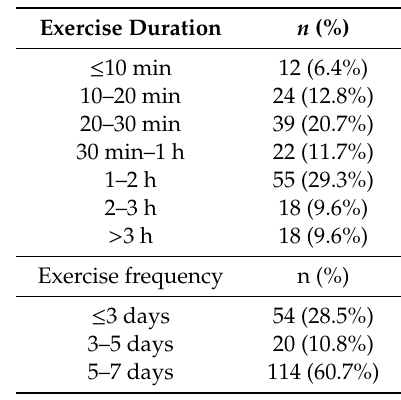
Table 5. Exercise duration and frequency of the participants in the green spaces.